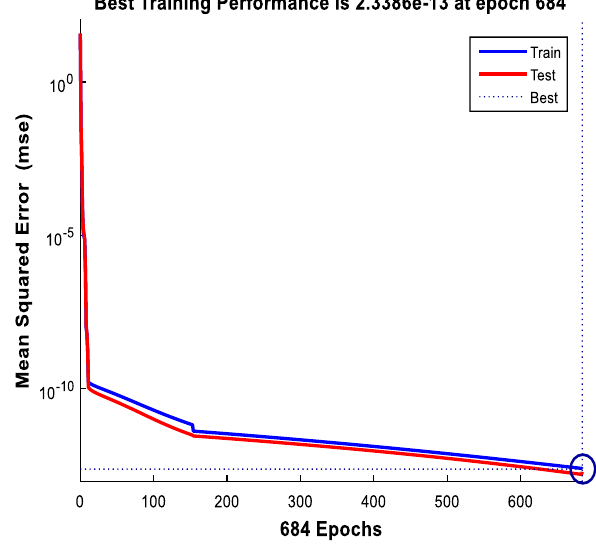
Table 8 Performance of different ANN models in estimation of iron